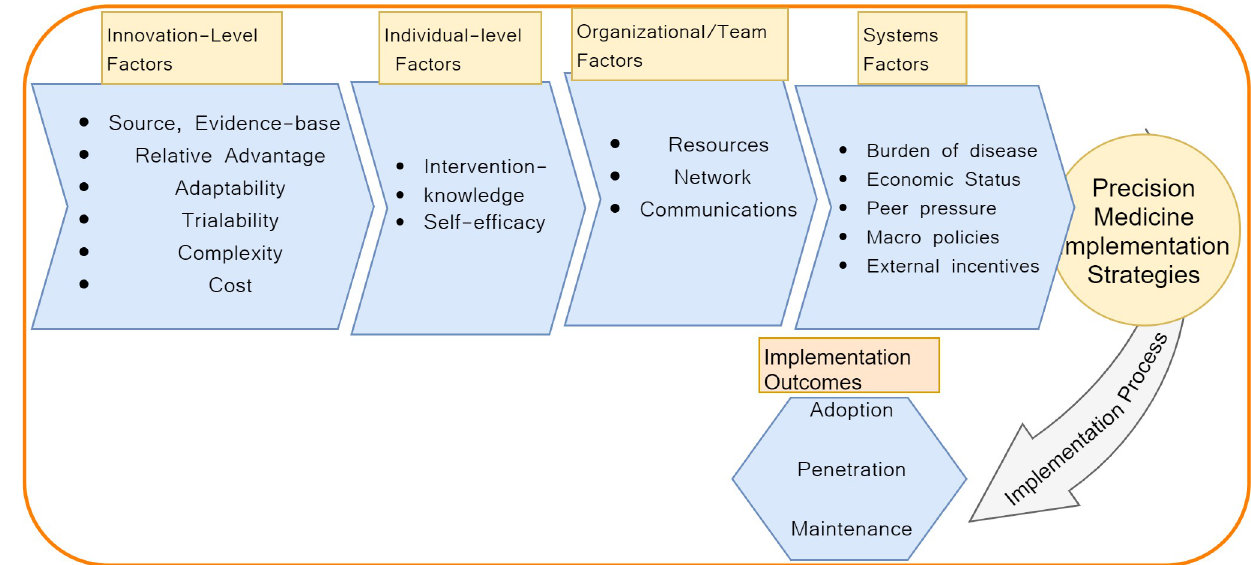
Fig 1. A precision medicine implementation meta-theoretical